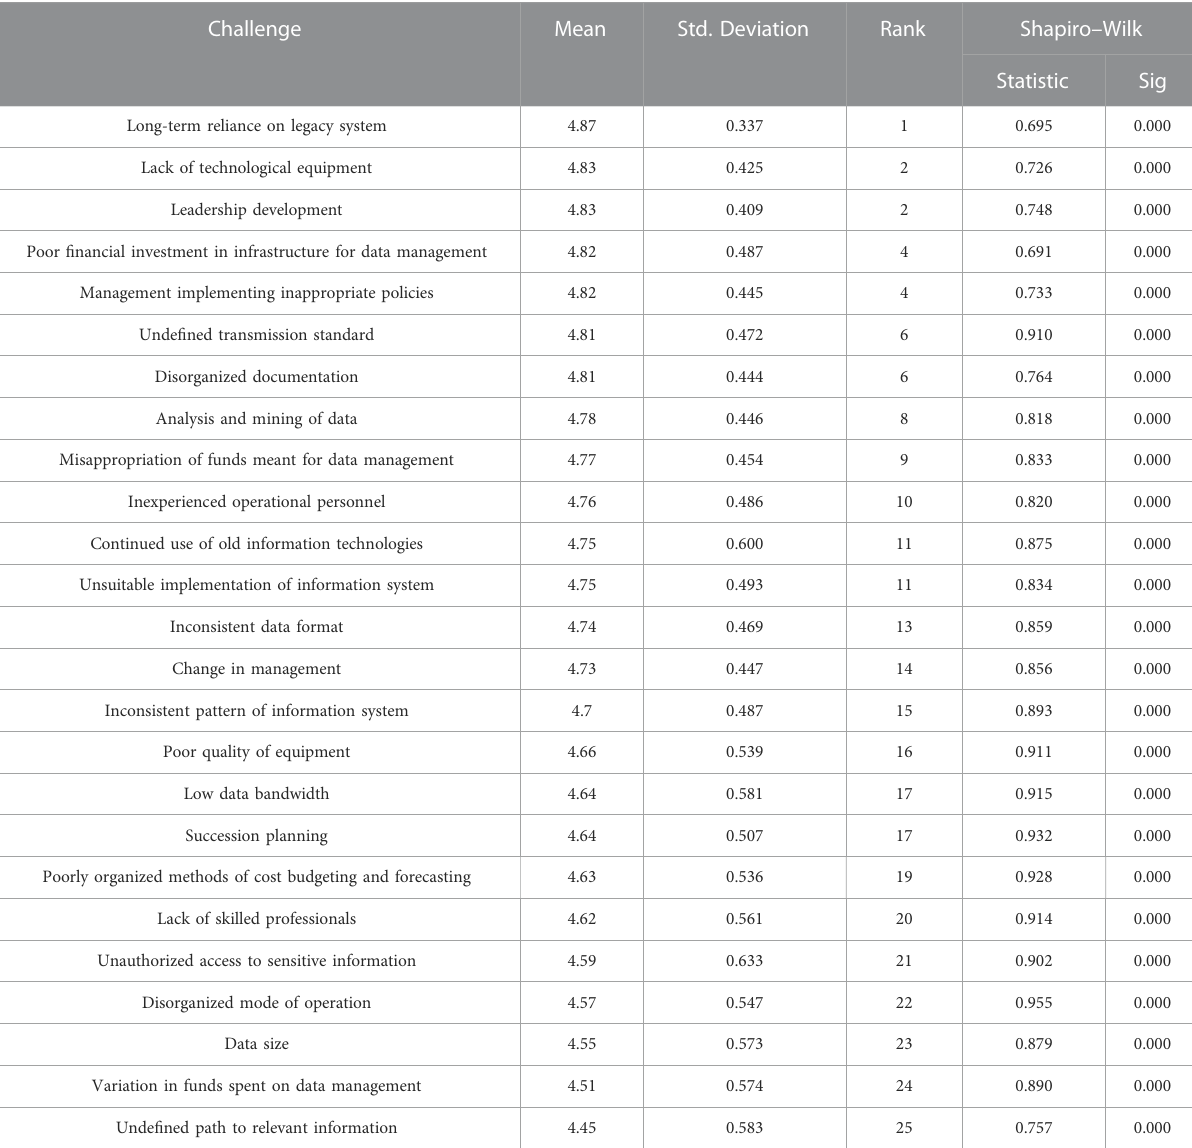
TABLE 2 Challenges in construction information